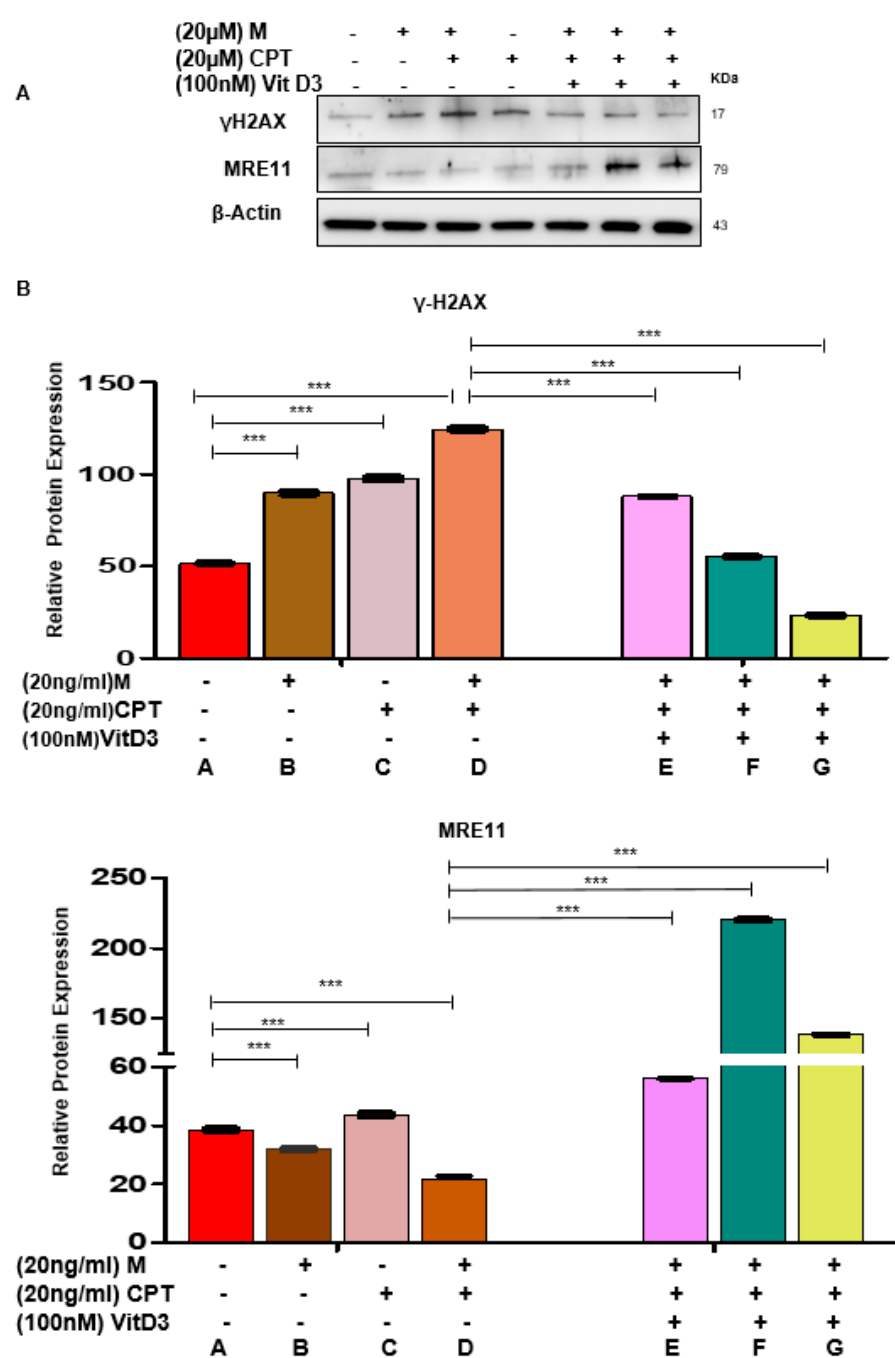
Figure 5. VitD3 antagonizes Camptothecin (CPT)- and Mirin-induced DNA damage in DES-MMSCs. ( A ) The protein levels of the DNA damage sensor γ H2AX and MRE11 were measured in DES-MMSCs with DNA-damage-inducer agents Mirin and CPT (20 µ g / mL) individually and in combination. The last three lanes represent the e ff ect of VitD3 (100 nM) on the γ H2AX and MRE11 levels in DES-MMSCs treated with CPT in combination with Mirin at di ff erent time points (1, 9, and 12 h). ( B ) Relevant data were used to create the corresponding data graph for γ H2AX (top panel) and MRE11 (bottom panel) in DES-MMSCs treated with VitD3 at di ff erent time points (1, 9, and 12 h) with *** p < 0.001. Full experimental design and explanation of di ff erent groups (A–G) are shown in Figure